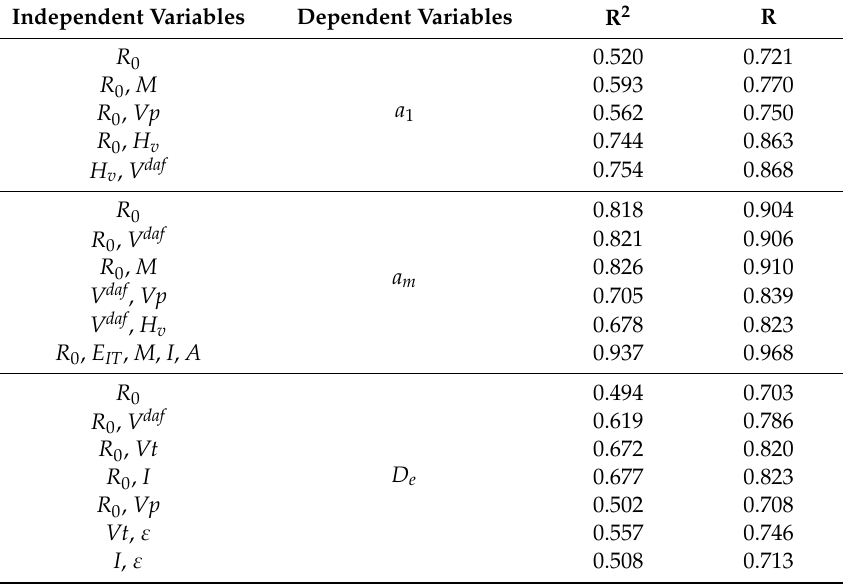
Table 4. Analysis of the fitting quality of various multiple regression